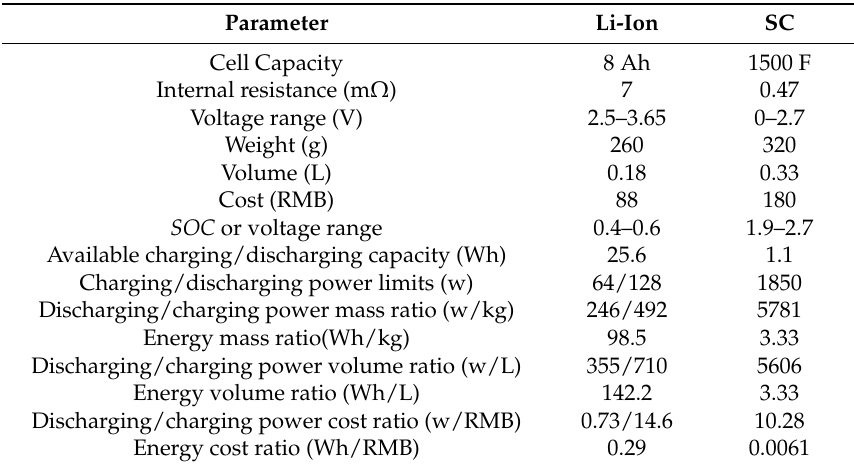
Table 3. Battery and SC cell specifications.